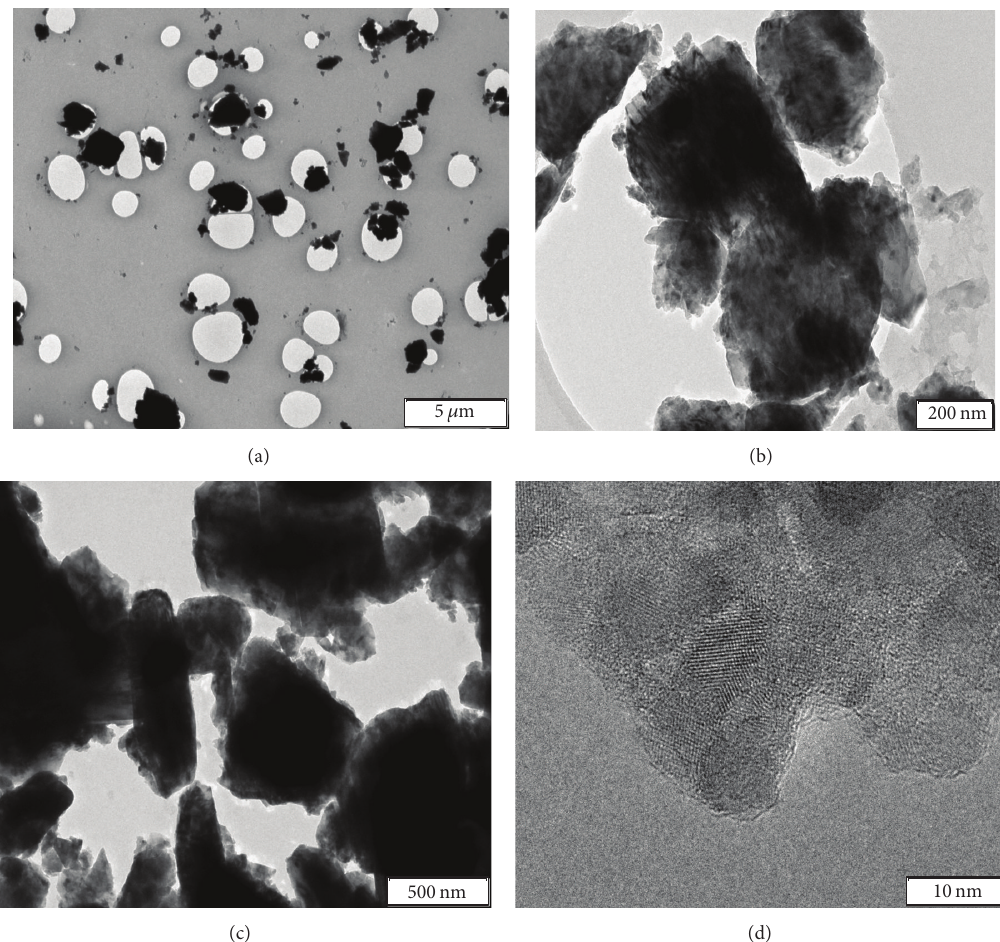
F 1: TEM picture of the titania powder produced by grinding of crystal